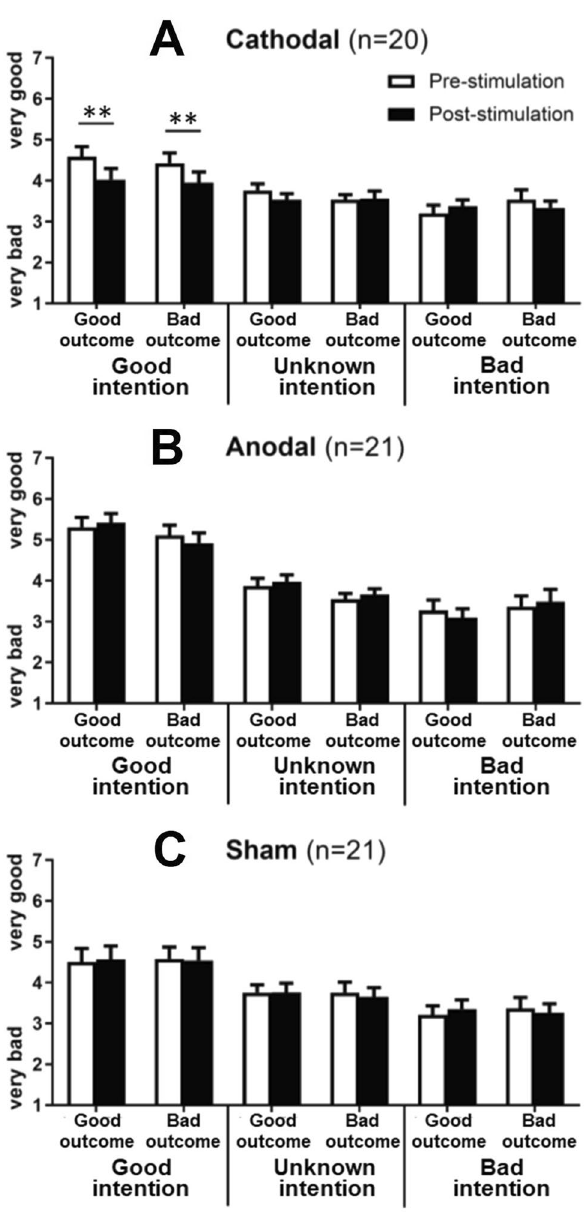
Figure 3. tDCS effects across experiments. Cathodal tDCS over the rTPJ diminished outcome evaluation when the intention is good. * p < 0.05, ** p <